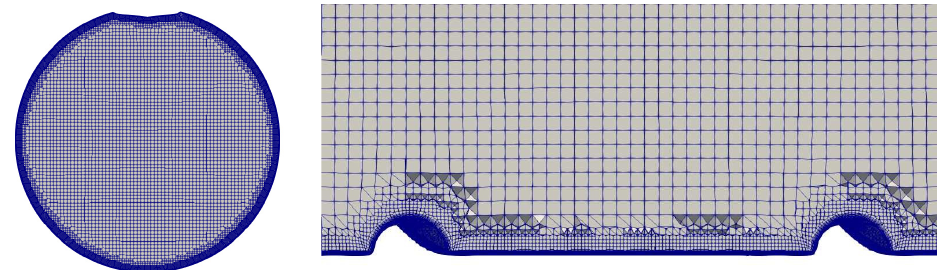
Figure 3. Display of the grid with layers at the inlet ( left ) and along the center ( right ) of the rib in RIB-2